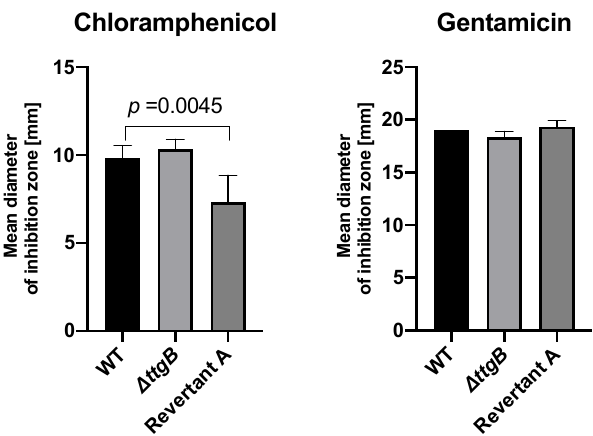
Figure 4. Susceptibility of the Revertant A strain to chloramphenicol. Susceptibility of wild type ∆ ttgB and Revertant A strains was tested against chloramphenicol in Mueller Hinton (MH) medium through disc diffusion method. Plates were incubated at 30 °C for 18 h, and the halo diameter was measured. Experiments were performed a minimum of three times.